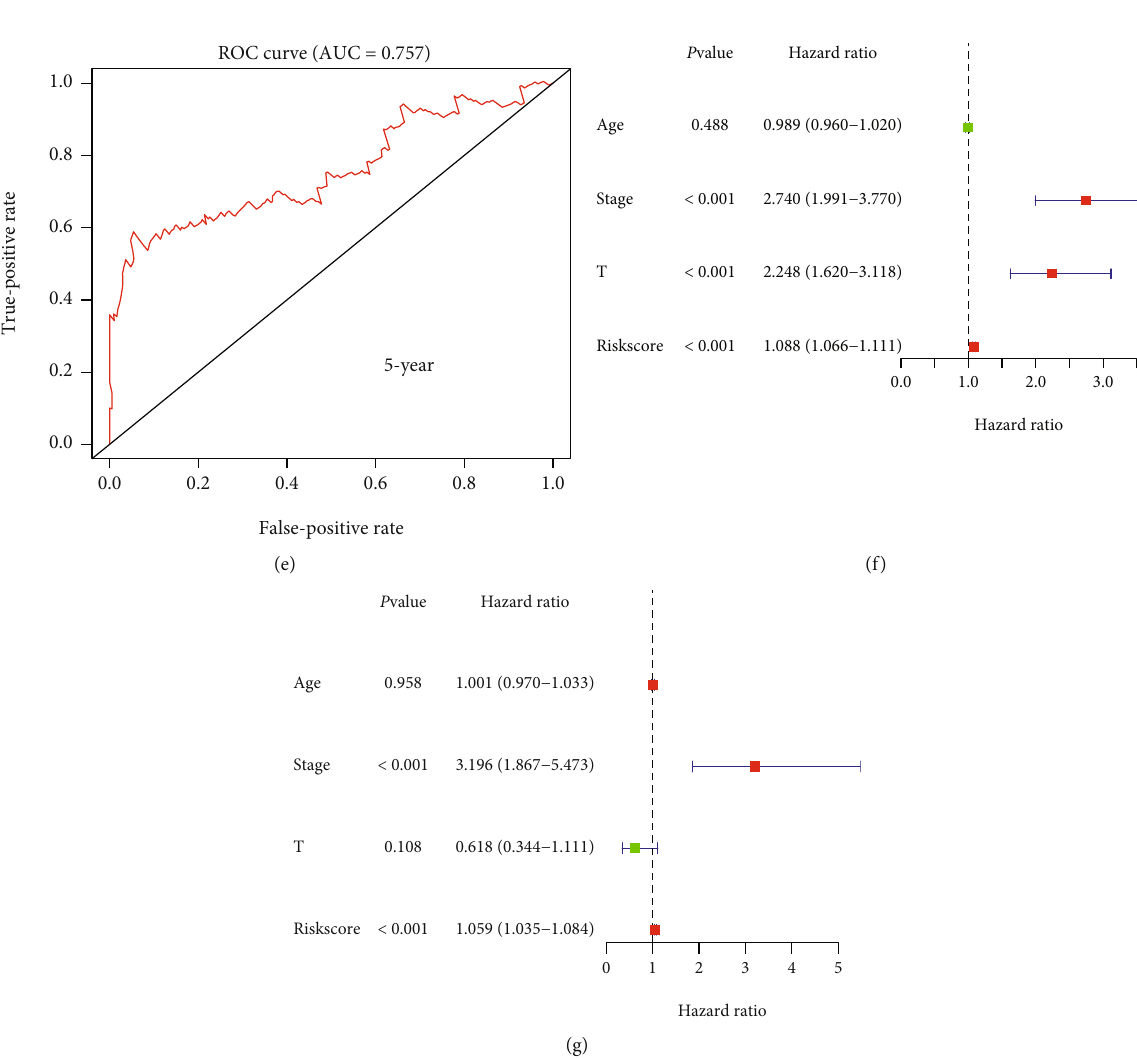
Figure 6: Risk signature in KIRP and its correlation with clinical characteristics. (a – c) The process of building the risk signature containing eight genes in KIRP. (d) Survival curve drawn based on the model. (e) Five-year ROC curve. Results for (f) univariate Cox analysis and (g) multivariate Cox